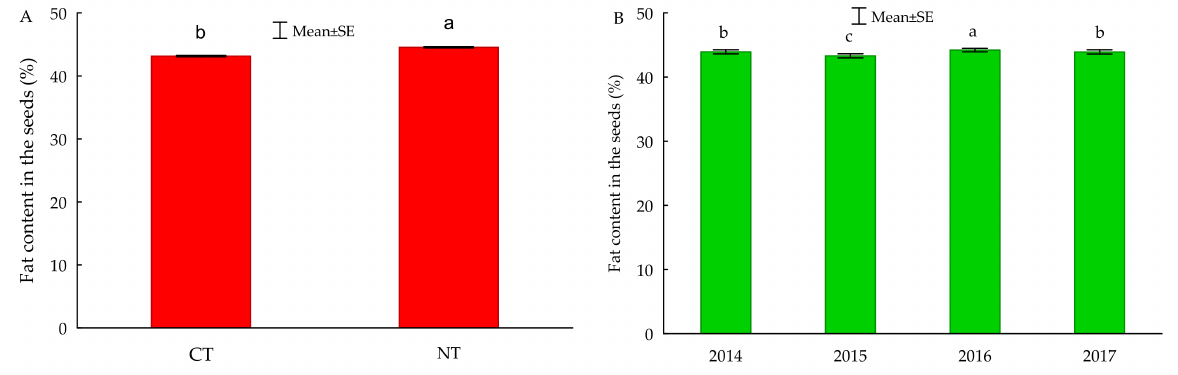
Figure 2. Fat content in winter oilseed rape seeds depending on the tillage system ( A ) (mean for 2014–2017) and years of research ( B ). CT—Conventional tillage; NT—No-tillage. Different letters denote significant differences ( p ≤ 0.05). The same letter means not significantly different